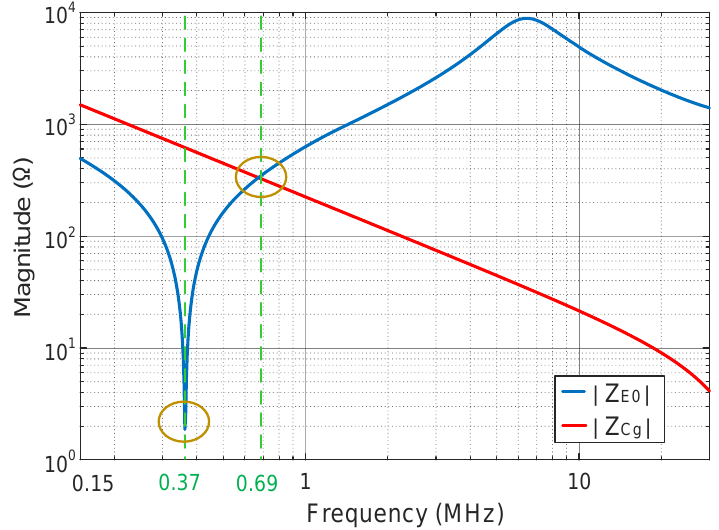
Figure 12. Magnitude spectra comparison between Z E0 (250 μH and 1 nF) and Z Cg .